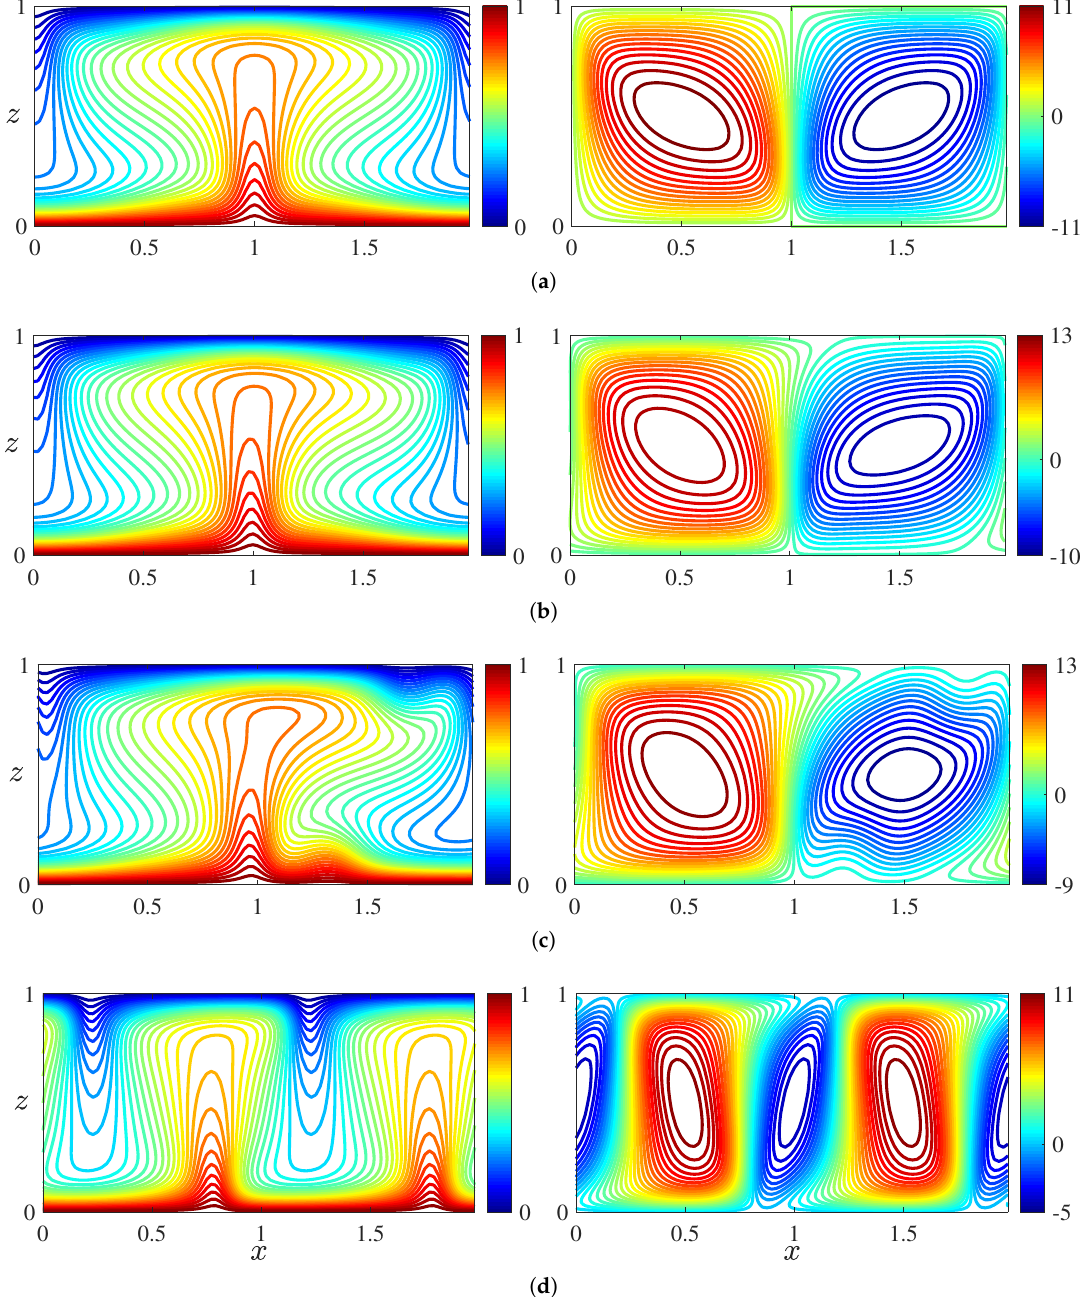
Figure 3. Snapshots of isotherms (left) and corresponding streamlines (right) from numerical simulations at Ra = 300 and L = 2. ( a ) φ = 0 ◦ ; ( b ) φ = 10 ◦ ; ( c ) φ = 17.5 ◦ ; ( d ) φ = 25 ◦ . In this case, the flows in ( a , d ) are steady; in ( b , c ), the upper and lower boundary layers of the antinatural rolls (negative ψ ) become unstable. At φ ≈ 25 ◦ , the small proto-plumes generated from the boundary-layer instabilities of the antinatural rolls split the unsteady two-cell convection (with one natural and one antinatural roll) into a steady four-cell convective state, thereby reducing the aspect ratio of each